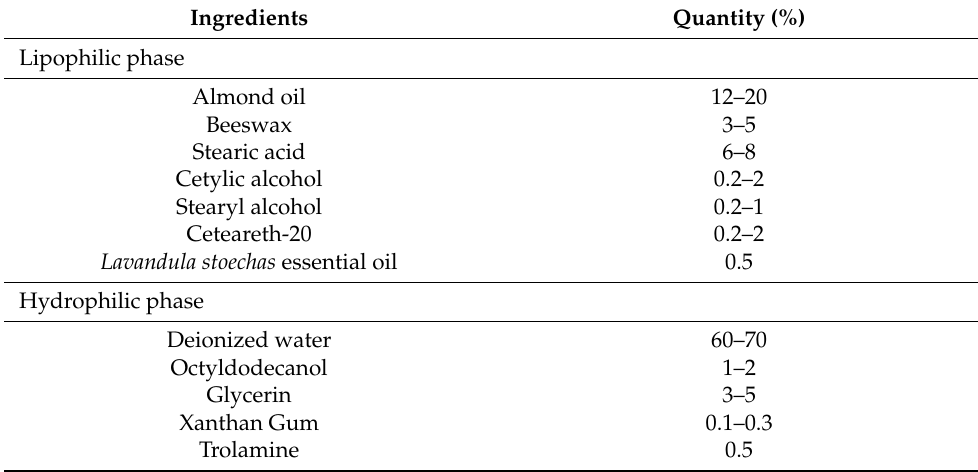
Table 1. Topical emulsion preparation with 0.5% of EOLS as a bioactive